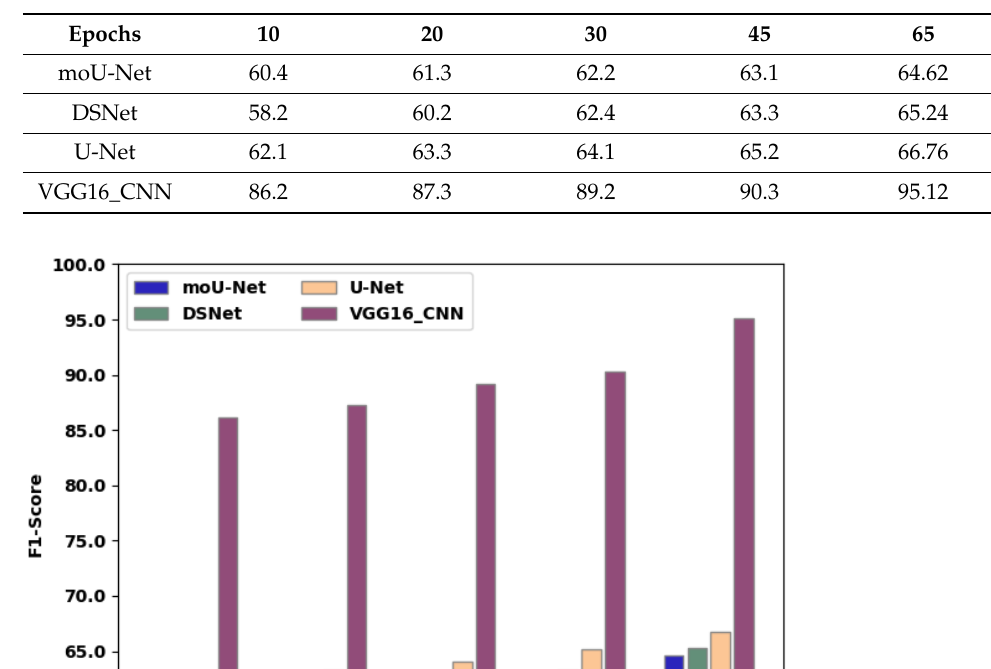
Figure 10. Recall comparison of the existing techniques and proposed methodology. Table 5. Comparison of F1-score over various epochs between existing techniques and proposed methodology.